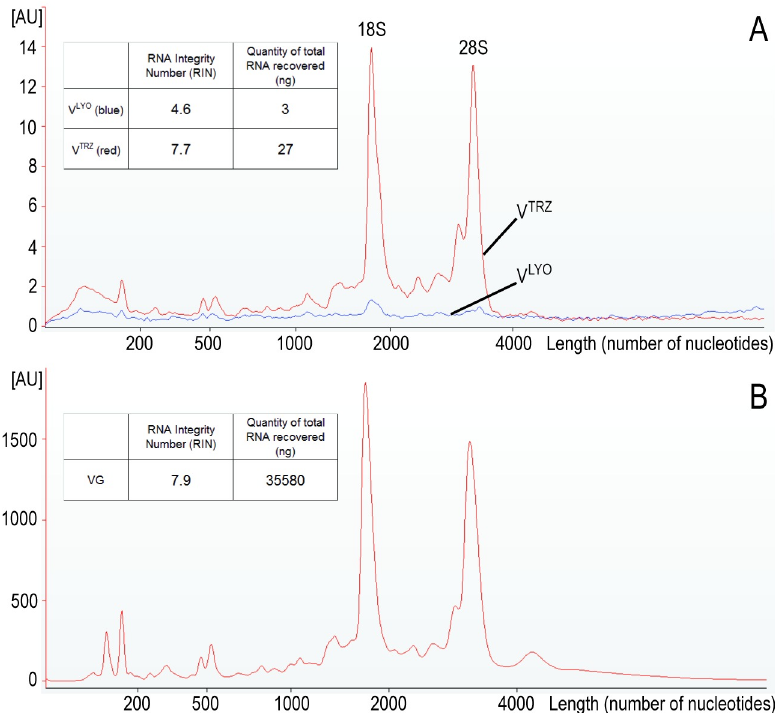
Fig 1. Quantitative and qualitative analysis of Bitis arietans total RNA isolated from lyophilized venom, TRIzol-treated venom and venom gland. (A) Lyophilized (V LYO , blue line), TRIzol-treated (V TRZ , red line) venom and (B) venom gland tissue. The y-axis is an arbitrary unit of fluorescence, and the x-axis shows the nucleotide length of the RNA. Note that the venom (A) and venom gland (B) electropherograms are presented with considerably different y-axis scale values reflecting the amount of RNA in the samples. RNA Integrity Number (RIN) and yield are shown as inserts. Key: venom gland (VG), venom (V), lyophilized (LYO), TRIzol-treated